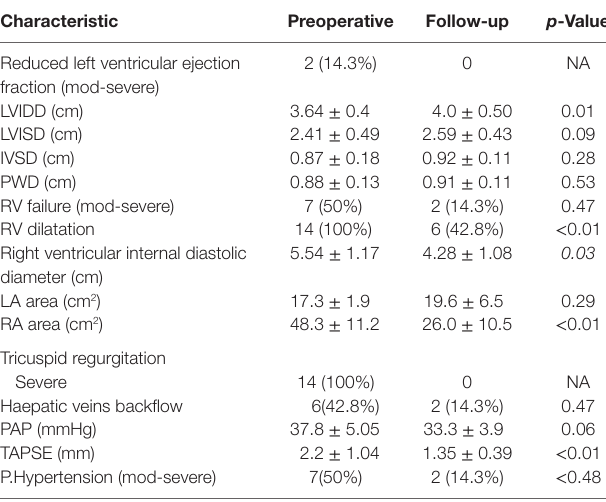
TaBle 6 | echocardiographic evaluations of patients with isolated tricuspid repair, subset analysis in ebstein population ( n = 14). characteristic Preoperative Follow-up p